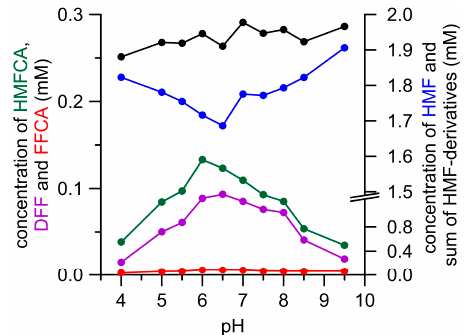
Figure 2. pH-Dependency of HMF oxidation by Aae UPO. HMF (blue), DFF (violet), HMFCA (green), FFCA (red), and sum of HMF derivatives (black). Only traces of 2,5-furandicarboxylic acid (FDCA) (<0.01 mM) were formed under these conditions.